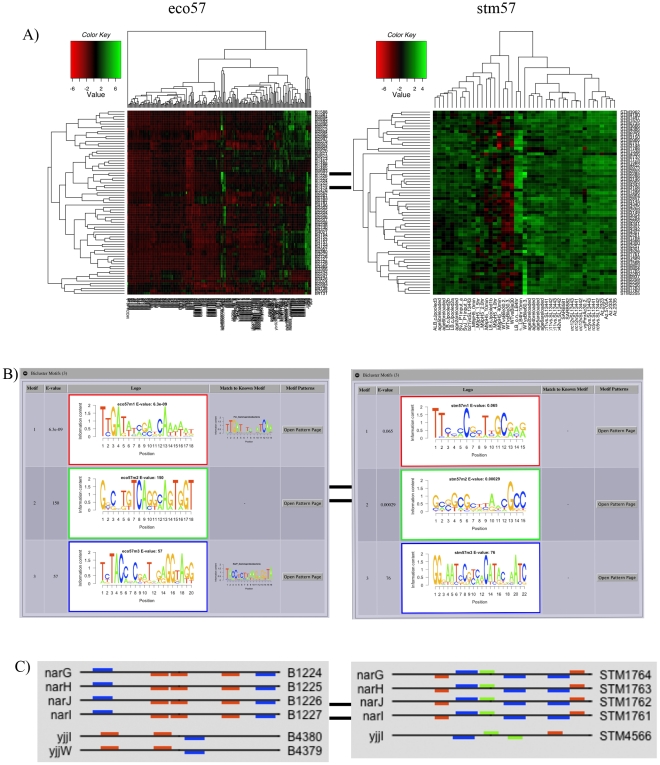
BiclusterCard components II: Bicluster Motifs, Upstream Patterns, Plots.Shown in the figure are, the expanded tab for Plots displaying a gene expression heatmap, the expanded tab for Bicluster Motifs, and an example of the upstream motif patterns for multi-species bicluster E. coli – S. Typhimurium bicluster 57. (A) Example plot of a gene expression heatmap for the bicluster genes and conditions in eco57 (left) and stm57 (right); upregulated expression (green) and downregulated expression (red). (B) Putative regulatory sequence motifs found in bicluster gene member promoters for eco57 (left) and stm57 (right). The table displays a row for each motif found and columns for the motif number, E-value, sequence logo, matches to any known motifs, and a link to motif pattern page. Eco57 motif #1 matches the known FNR binding sequence and motif #3 matches the known NarP binding sequence. (C) The promoter motif patterns for the motifs shown in (B) for eco57 (left) and stm57 (right). The location of the motifs are represented by colored rectangles on the promoter sequence (black line) and the colors correspond to the logo border colors seen in (B); motif #1 (red), motif #2 (green) motif #3 (blue). For the bicluster gene members shown, bicluster motifs #1 and #3 appear in the promoter regions of the eco57 members, whereas all three bicluster motifs appear in the promoters for the stm57 members. The identical motif pattern indicates MScM has determined them to be in an operon. It is known that narGHJI exist as an operon, but MScM has determined that yjjI is in an operon with yjjW (this is also predicted by [62]). However, yjjW is found only in the elaborated gene set of eco57 and it is not found in stm57.